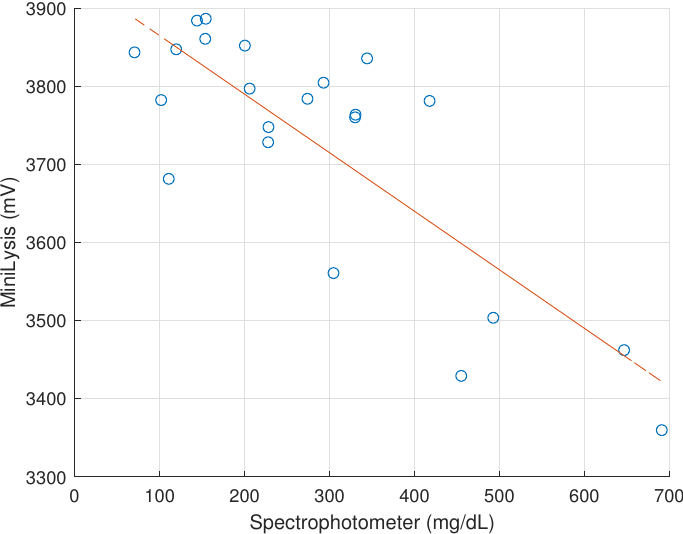
Figure 10. Linear regression relation between outputs of the minilysis prototype and the